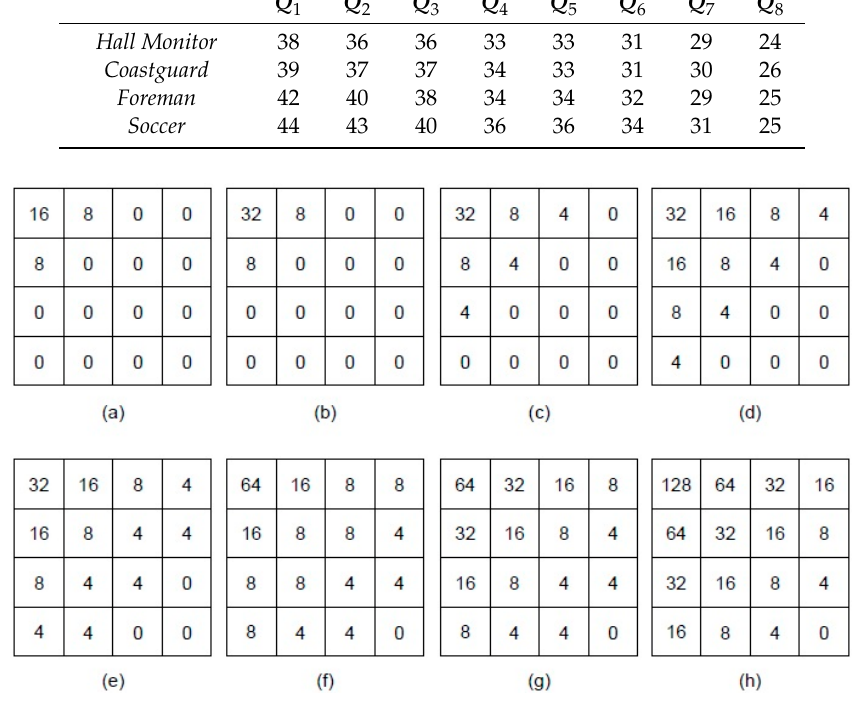
Figure 6. Fixed set of eight quantization matrices (QMs).